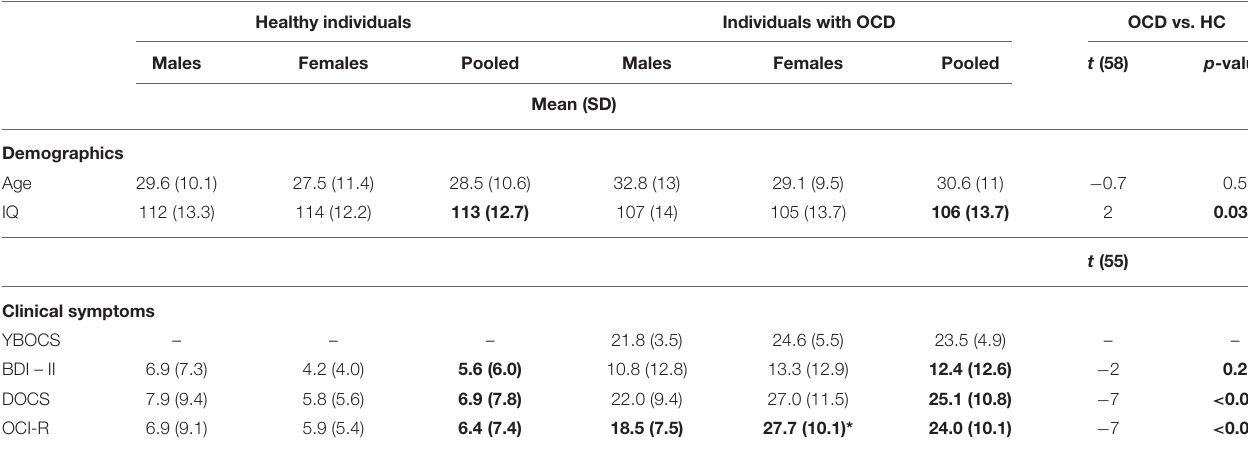
TABLE 1 | Demographic and clinical characteristics of the study participants. Healthy individuals Individuals with OCD OCD vs.